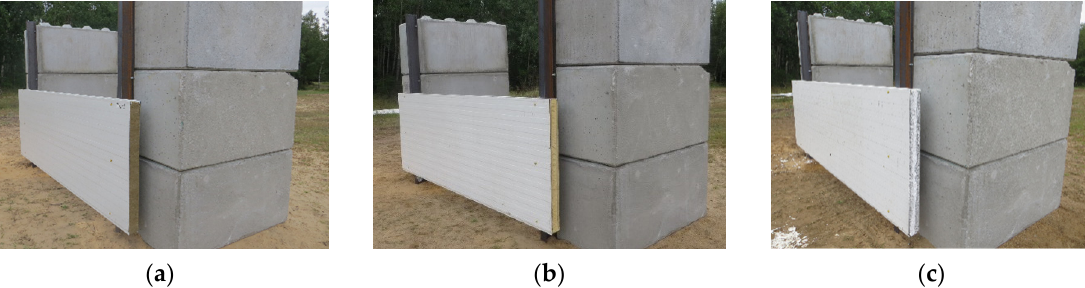
Figure 1. View of the field test setup, showing the installed sandwich panel with the core made of the different core materials: ( a ) mineral wool; ( b ) polyisocyanurate foam; and ( c ) expanded polystyrene.